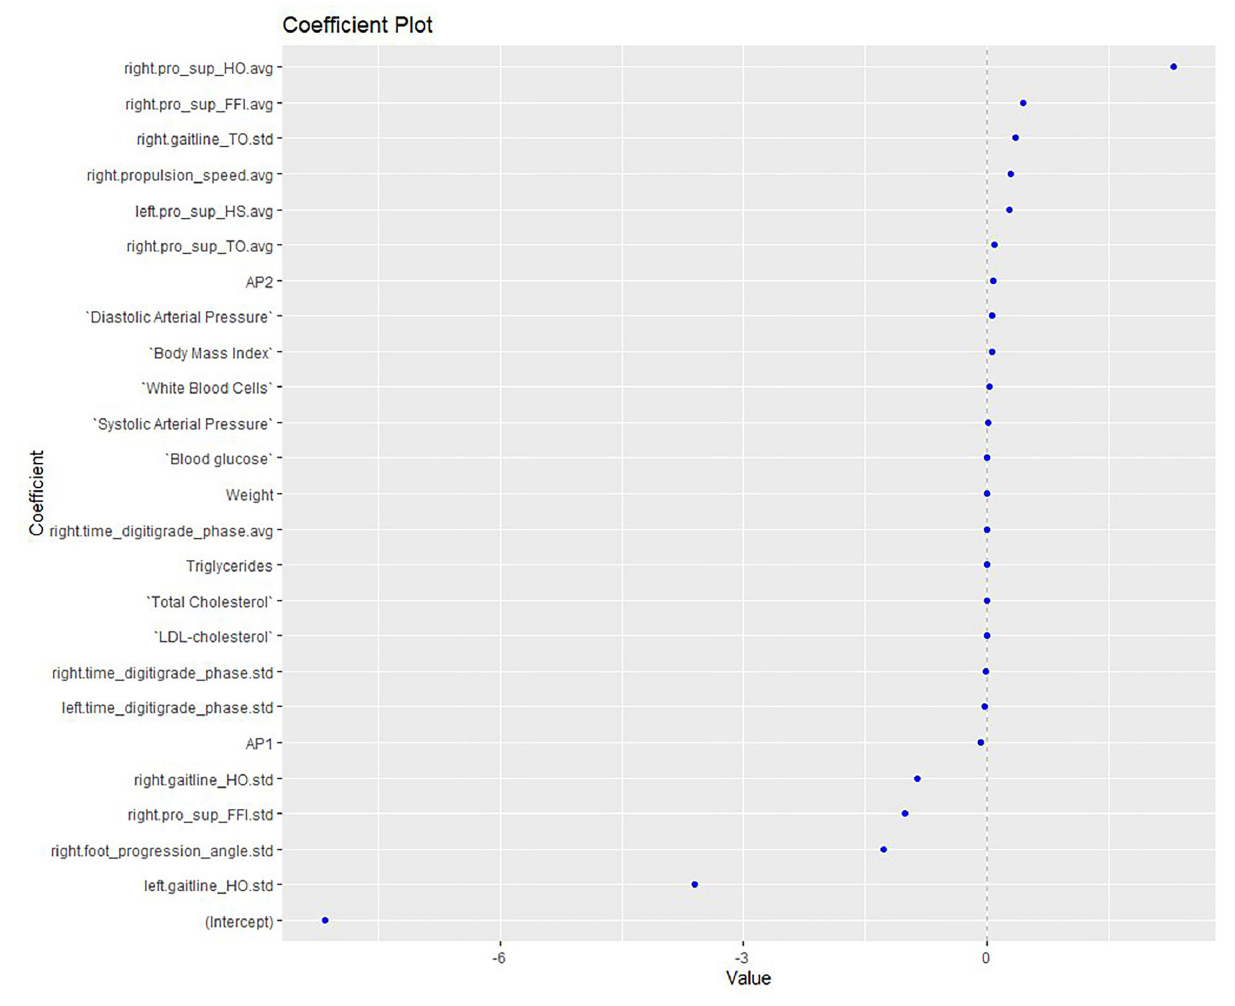
FIGURE 1 | Elastic net model exploring the APs, anthropometric and biomarkers associated with the risk of MetS. HO, Heel off; FFI, Flat foot in; TO, Toe off; HS: heel strike; Pro, pronation; Sup, supination; avg, average; std, standard deviation; AP, antipsychotics; LDL, low-density